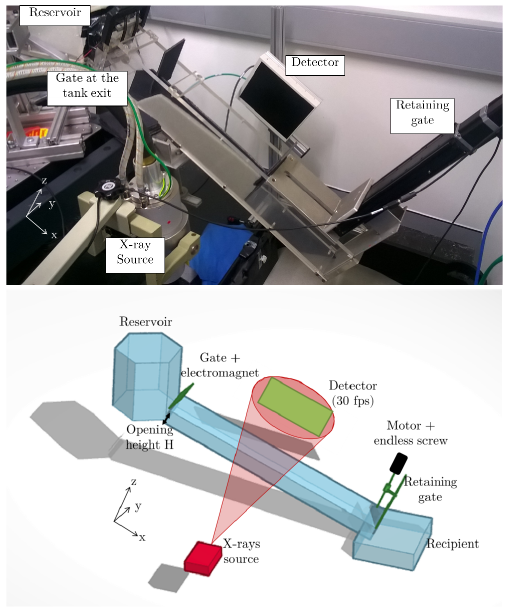
Figure 1. Photograph of the laboratory granular chute to produce standing jumps, installed in the X-ray room (top panel). Sketch of the granular chute showing the main elements: tank, channel, two automatic gates at the tank exit and end of the chute, and X-ray source and detector.